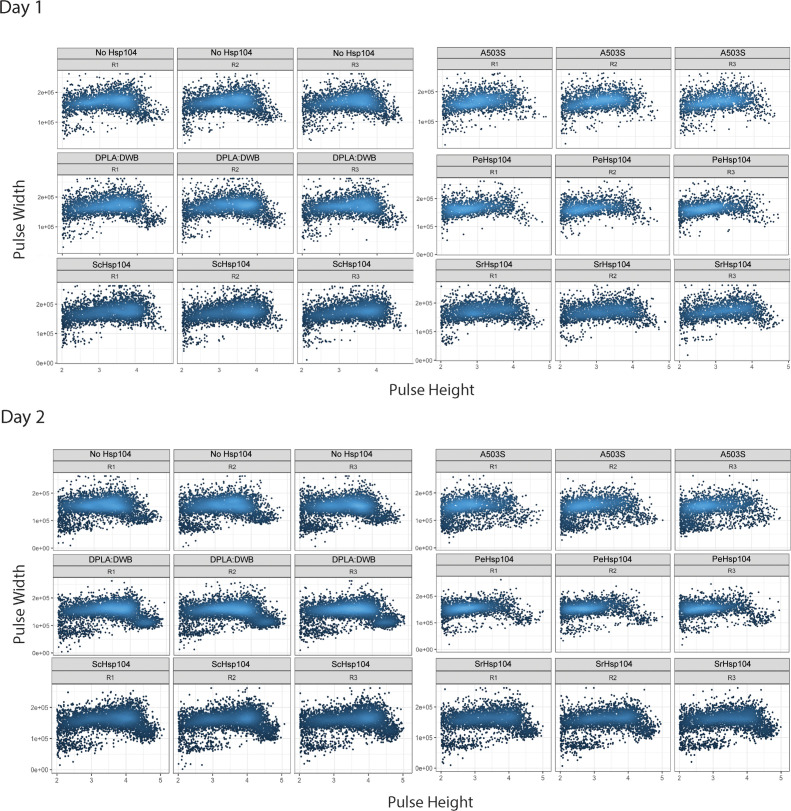
Pulse-shape plots for HEK293T TDP-43ΔNLS co-transfection experiments.HEK293T cells were cotransfected with doxycycline-inducible constructs encoding mClover3-TDP-43ΔNLS. Protein expression was induced with 1 µg/ml doxycycline 6 hr post-transfection. At varying times, cells were sorted by FACS. Flow cytometry plots for each co-transfection experiment are shown. Each condition (no Hsp104, DPLA:DWB, ScHsp104, A530S, PeHsp104, and SrHsp104) is shown in three replicates (R1–R3) on day 1 (upper panels) and day 2 (lower panels). In each plot, the x-axis shows the pulse height and y-axis the pulse width. A small separate population of cells with low width and high height is observed in the bottom right of most plots representing the group of cells where the measured fluorophore is aggregated.